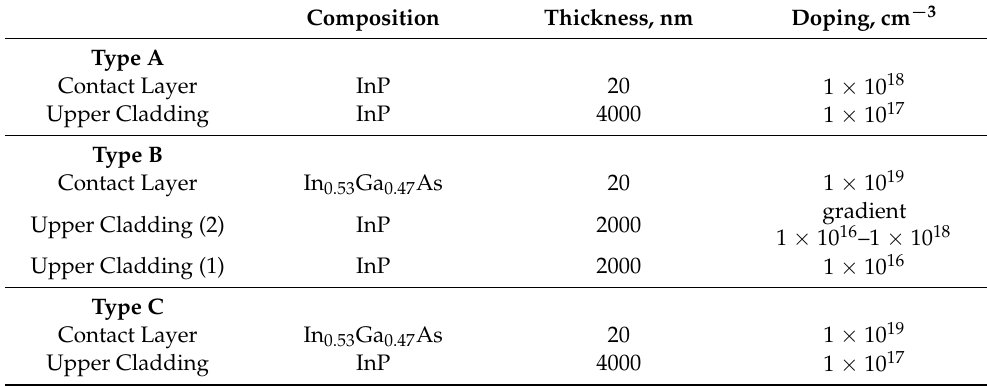
Table 1. Upper cladding/contact layer designs. The QC configuration used for the structures of Types A–C comprised a superlattice of alternating In 0.53 Ga 0.47 As /Al 0.48 In 0.52 As layers that were lattice-matched with the InP substrate [11]. The thicknesses of the sequential layers